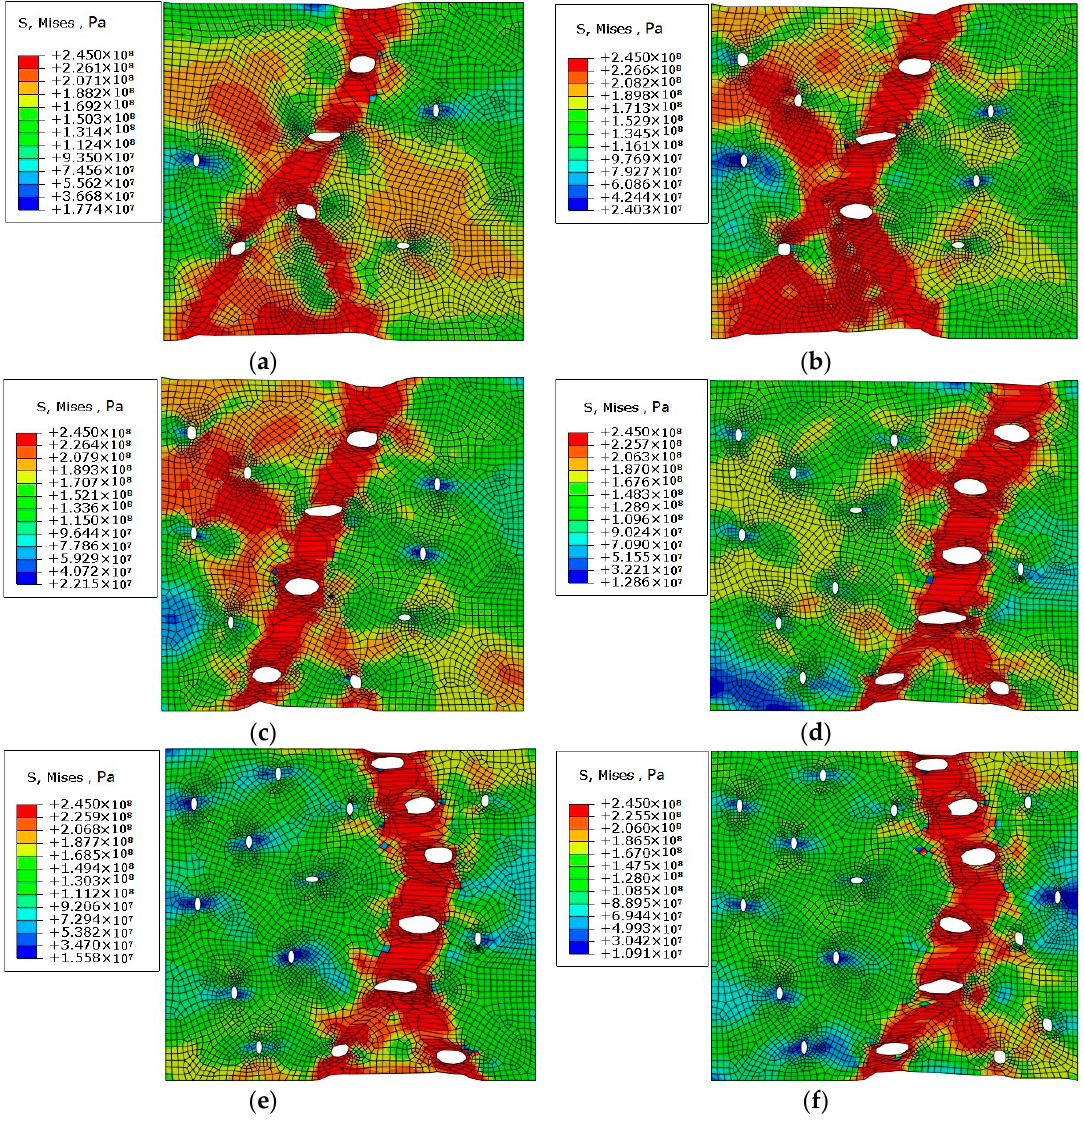
Figure 17. Stress distribution diagram of a polycrystalline model with different porosity of ( a ) 0.40%, ( b ) 0.60%, ( c ) 0.75%, ( d ) 0.90%, ( e ) 1.10%, and ( f ) 1.30%.